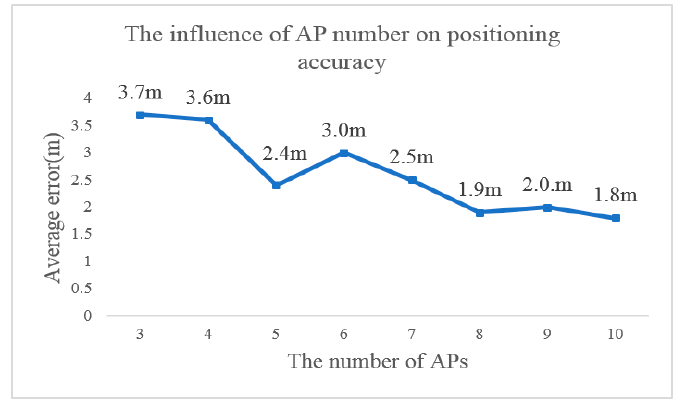
Figure 16. The average positioning accuracy under different reference point densities.